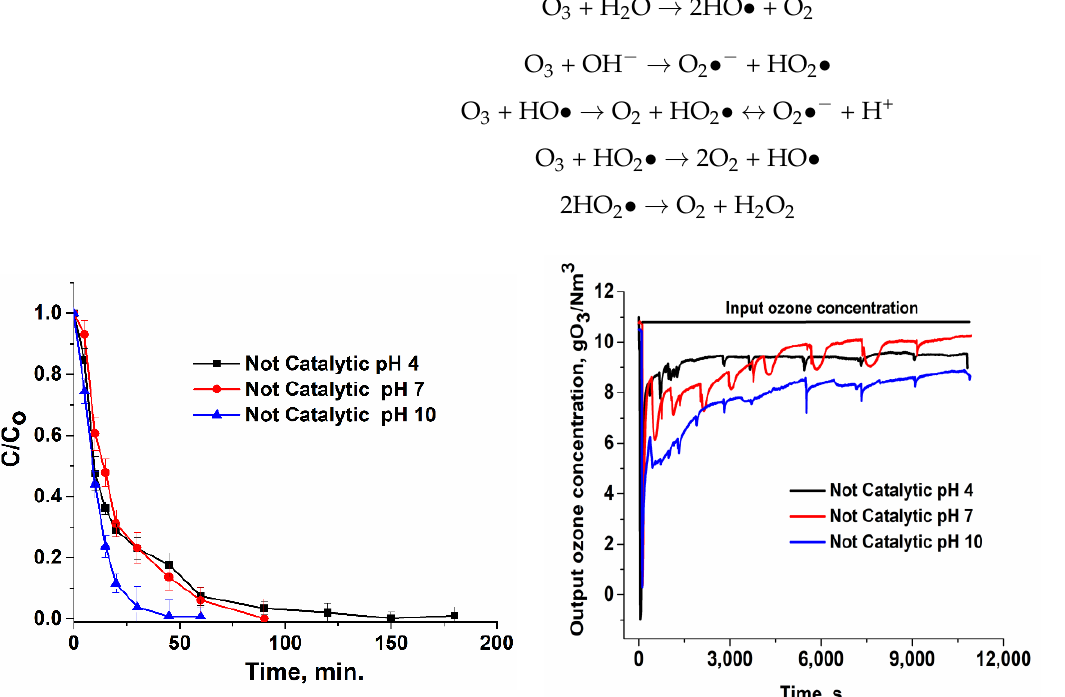
Figure 7. Variation in the normalized ibuprofen concentration and ozone concentration for the non-catalytic process.